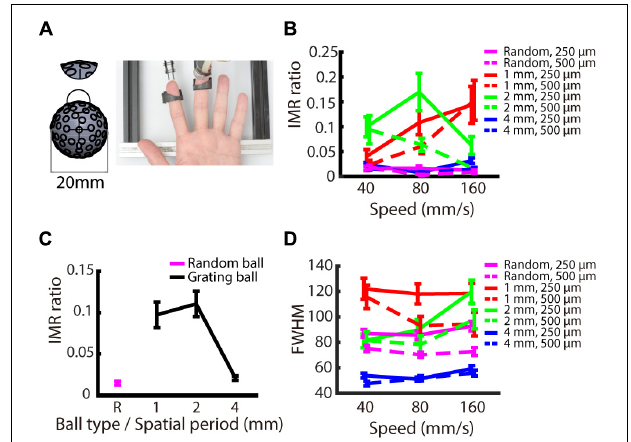
FIGURE 6 | Experiment 3: Orientation dependence on IMR. To examine whether orientation information is necessary to induce IMR, we presented a random-dot pattern ball. (A) Experimental apparatus. The random-dot pattern ball had dots randomly arranged on the ball surface with the average dot-to-dot distance of 3 ± 1 mm. The miniature ball stimulator and hand position were the same as those in Experiments 1 and 2. (B) IMR ratios across different ball types, including spatial period, speed, and indentation depth combinations. (C) The random-dot pattern induced the lowest IMR ratio compared with the grating balls for the spatial periods of 1 and 2 mm (1 mm vs. random-dot, F ( 1 , 216 ) = 15.125, p < 0.001; 2 mm vs. random-dot, F ( 1 , 216 ) = 13.530, p < 0.01) but not for gratings with spatial period of 4 mm (4 mm vs. random-dot, F ( 1 , 216 ) = 0.049, p = 1). (D) FWHM across different ball types, including spatial period, speed, and indentation depth combinations. Bars indicate standard error of the